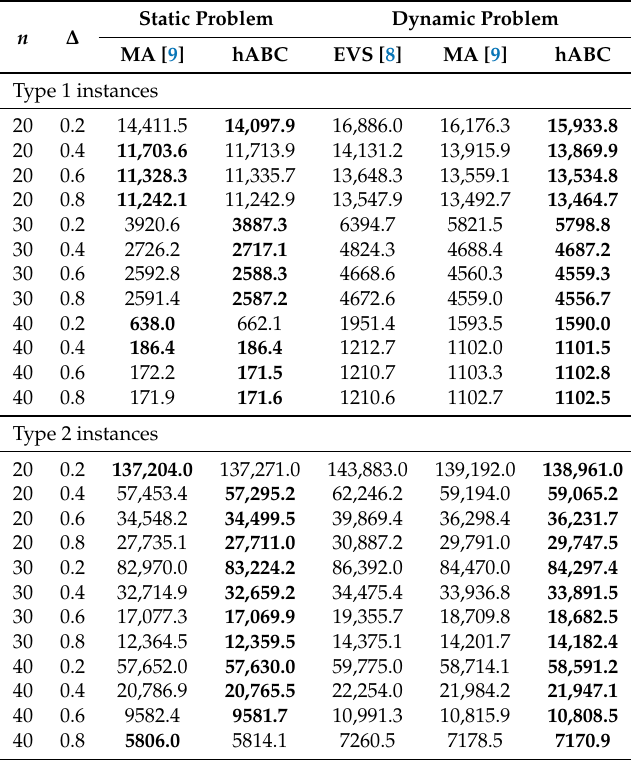
Table 3. Comparison of hABC to the state-of-the-art methods on the instances of scenario 2. The best values obtained for each set of instances are remarked in bold.